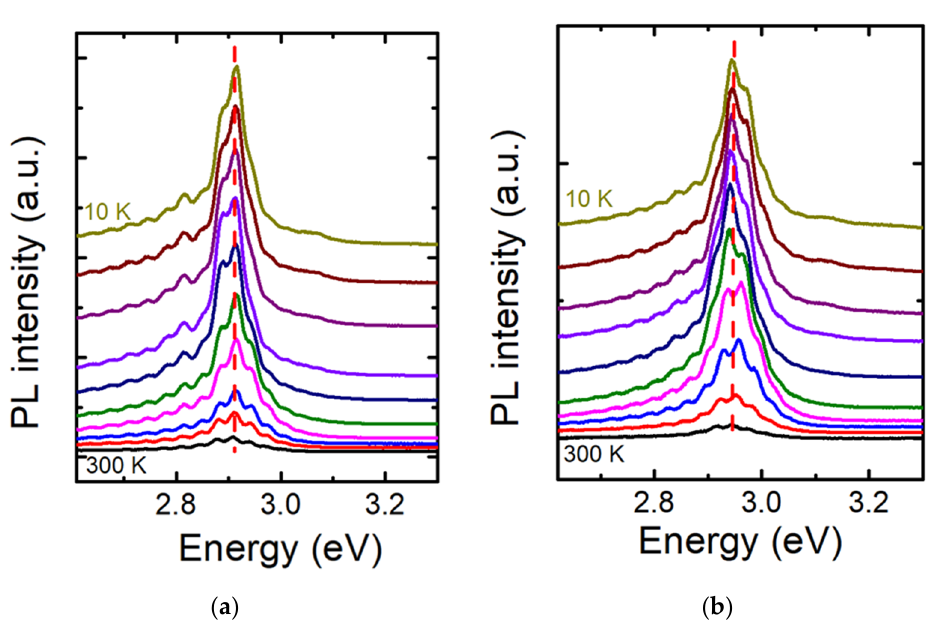
Figure 2. PL spectra of ( a ) Sample 1 and ( b ) Sample 2 recorded in a temperature range of 10 K to RT.